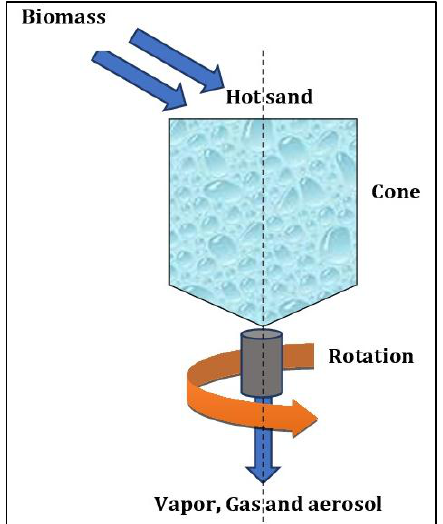
Figure 8. Rotating cone reactor. Table 6. Summary of previous researches on biomass conversion.